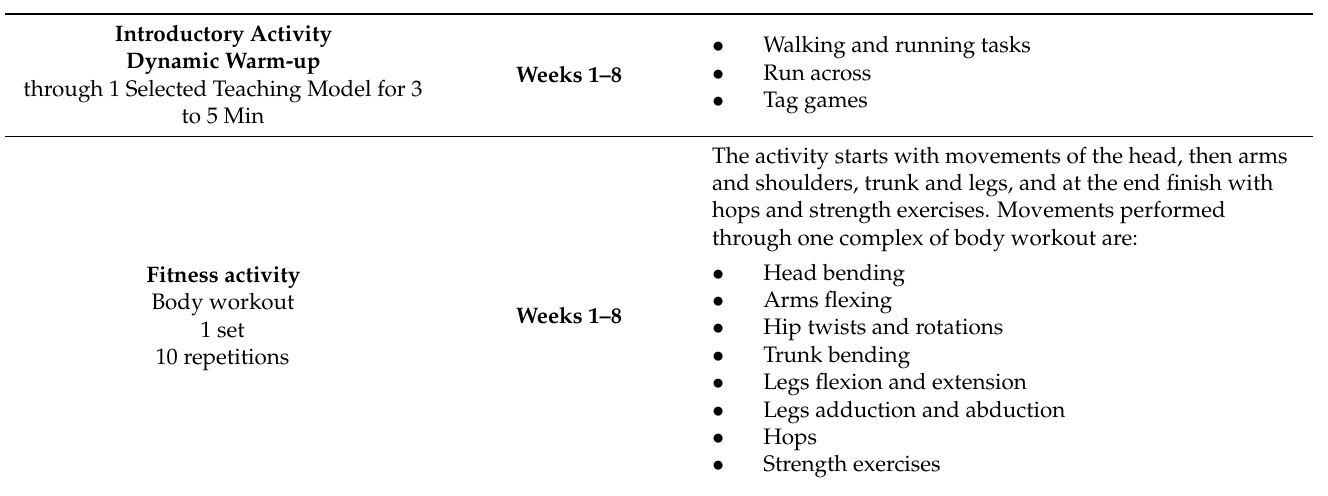
Table 3. Structure of the CG